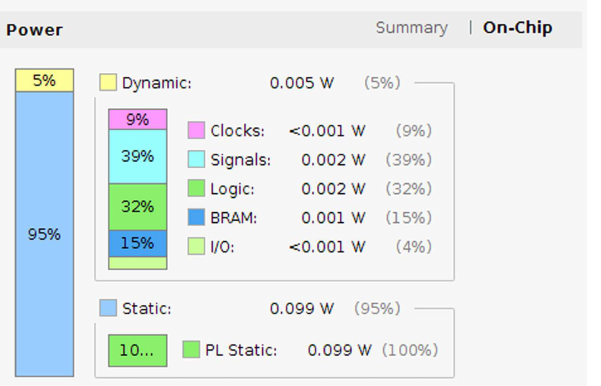
Figure 5. Original Image.